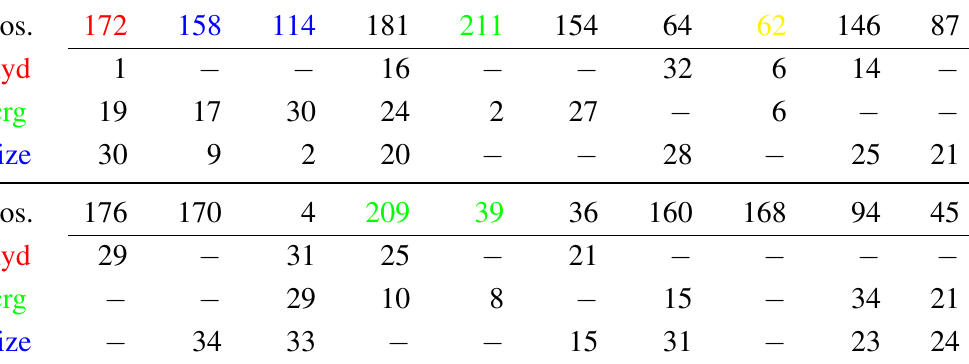
Table 8. Substitution class based runs over SDPs relevant to tetramer to dimer transforma- tion. Ranking and color coding as in Table 2. We chose to study the positions that had not been validated experimentally, since these are the new possibilities for putative mutations. For each position, its ranking in any specific run is shown. “ − ” means that in that run, the position ranked below 40 th .